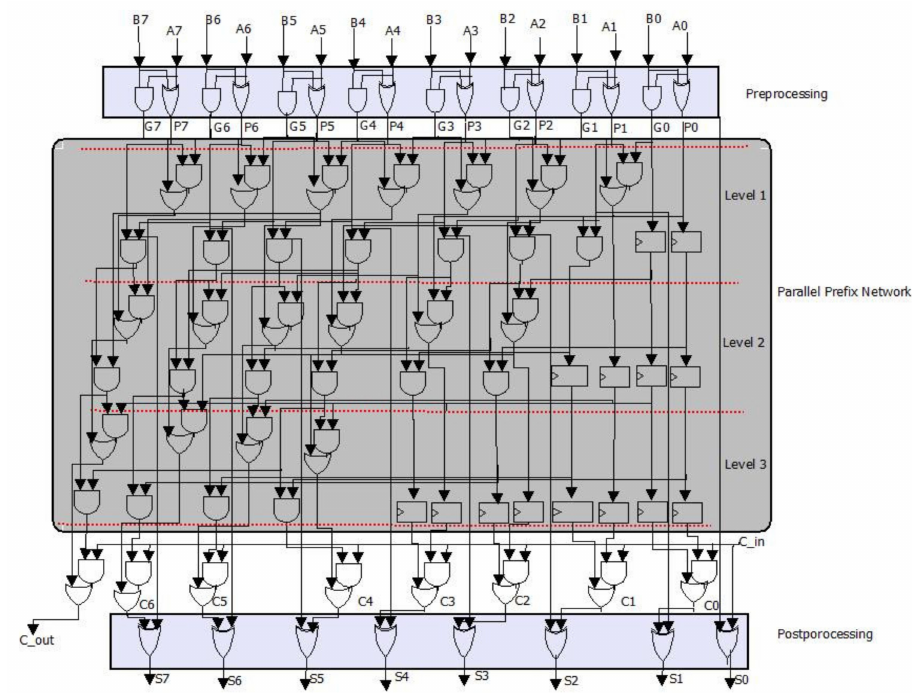
Figure 4. Eight-bit G-KSA/S